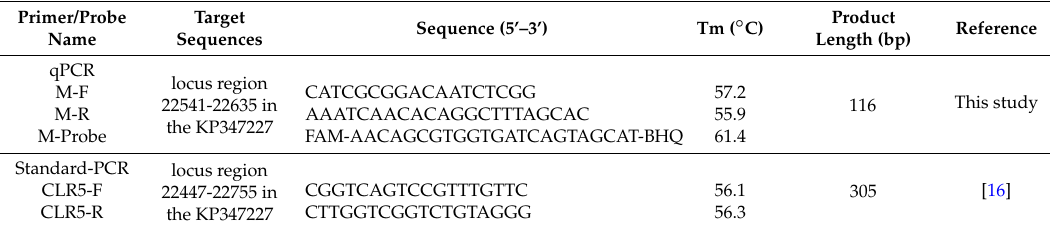
Table 1. Primers and probe designed to target the mcr-1